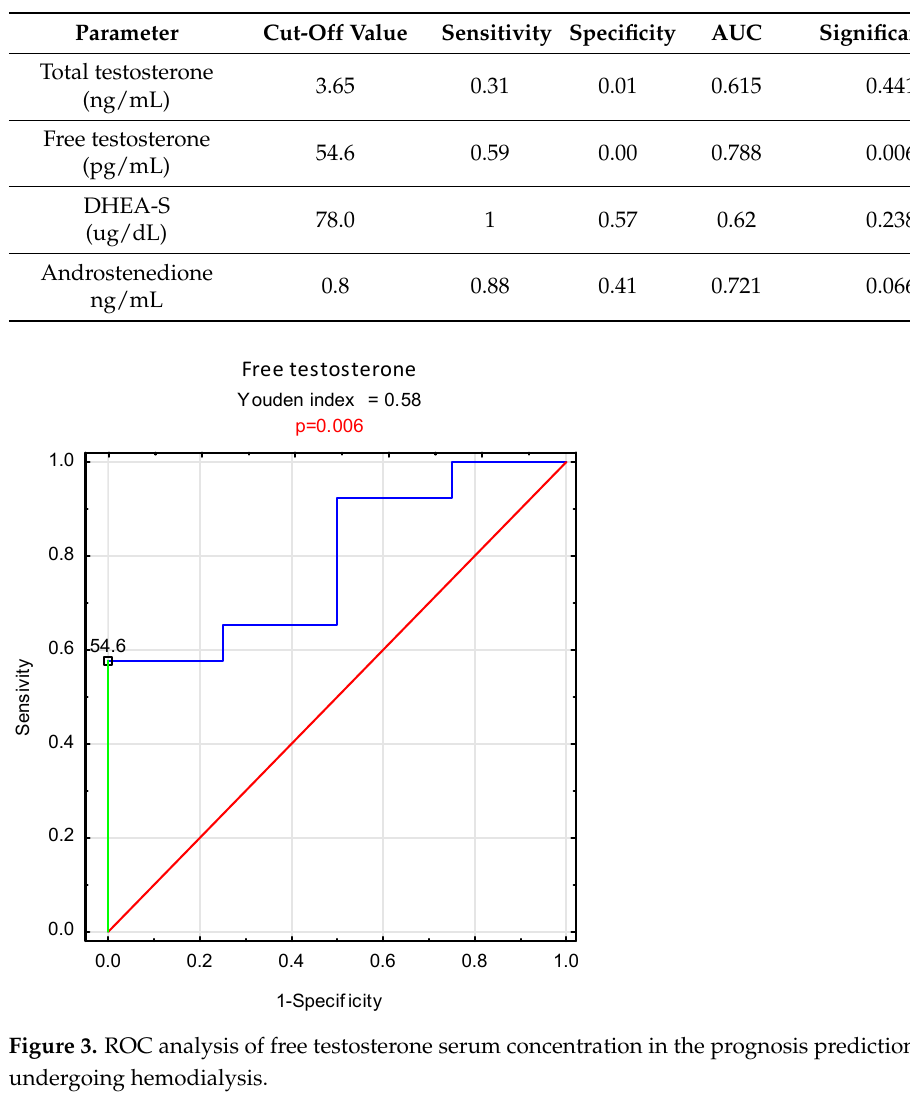
Figure 2. The probability of survival in the group of men on dialysis depending on the concentration of total testosterone in the blood serum. Table 5. ROC analysis of androgen serum concentration in the prognosis prediction in men undergoing hemodialysis.